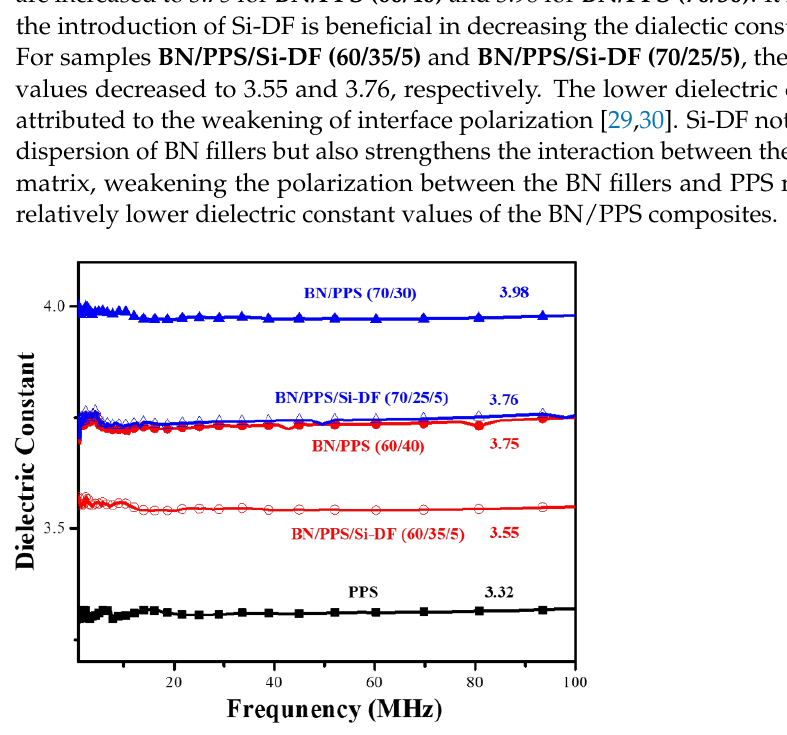
Figure 6. Dielectric constant-frequency curves of PPS matrix and BN/PPS composites.